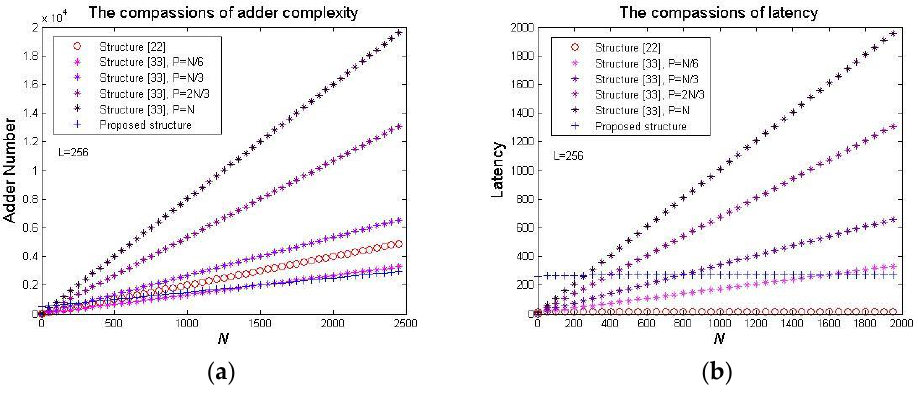
Figure 12. The three structure’s adder number and latency: (a) Adder (b) Latency.